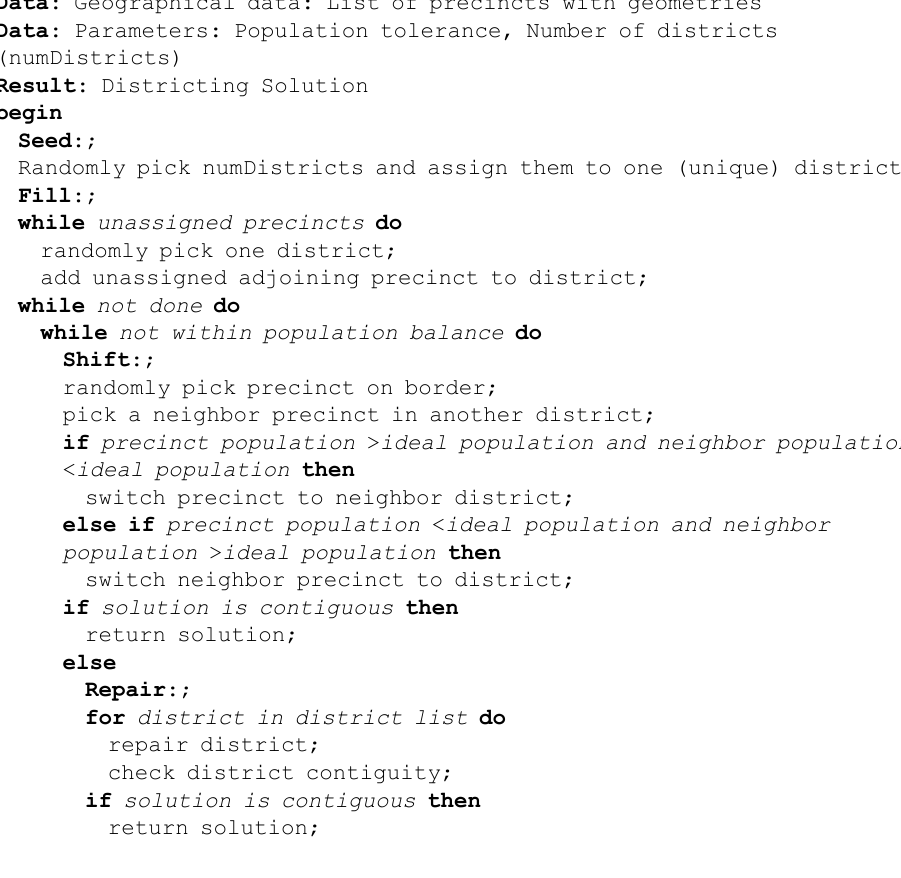
Algorithm 1 : Pseudocode of Seed-Fill-Shift-Repair Algorithm for